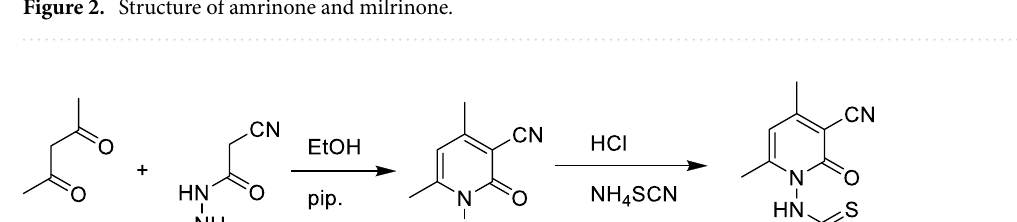
Figure 2. Structure of amrinone and